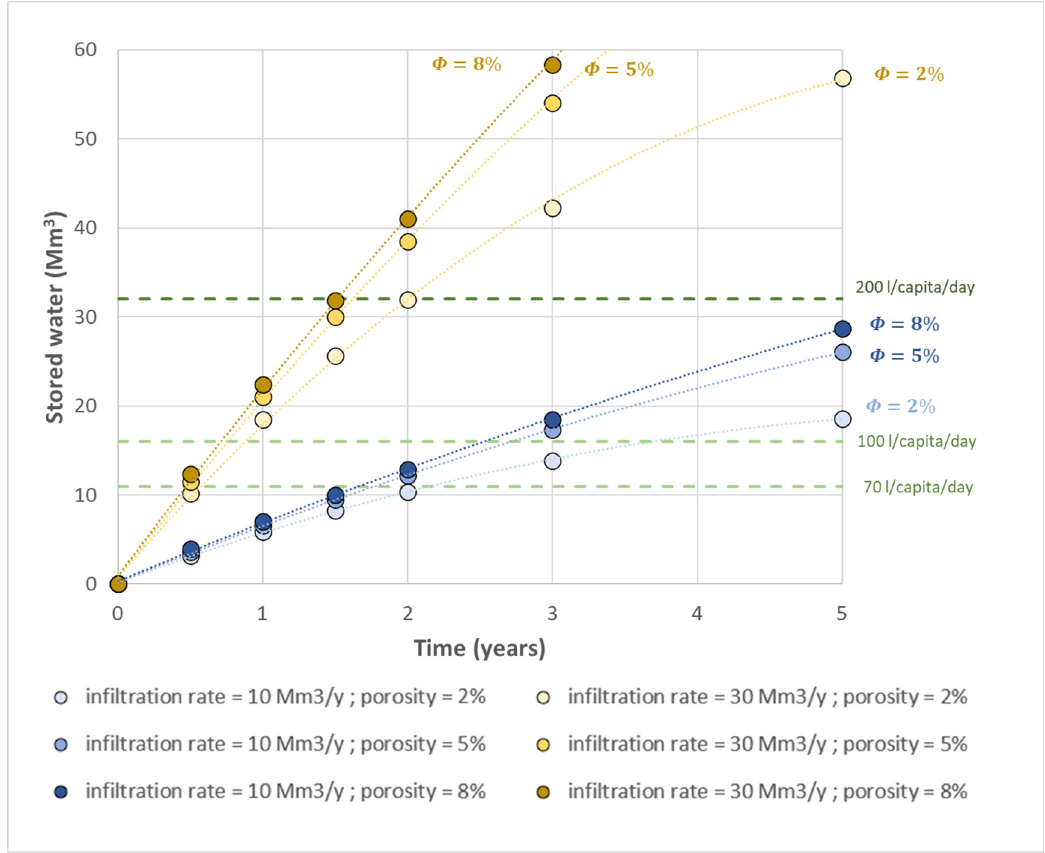
Figure 9. Evolution of the volume of stored water over 5 years depending on porosity values and infiltration rates. Table 3. Time (year) needed to reach the required amount of water storage (* objective not reached within 5